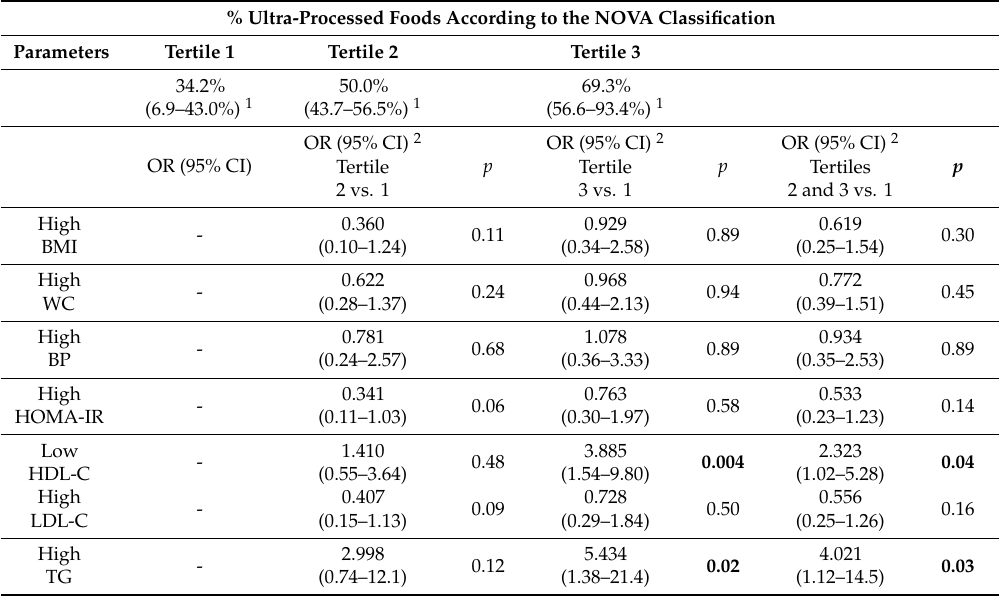
Table 4. Associations between ultra-processed foods and anthropometric and metabolic parameters. % Ultra-Processed Foods According to the NOVA Classification